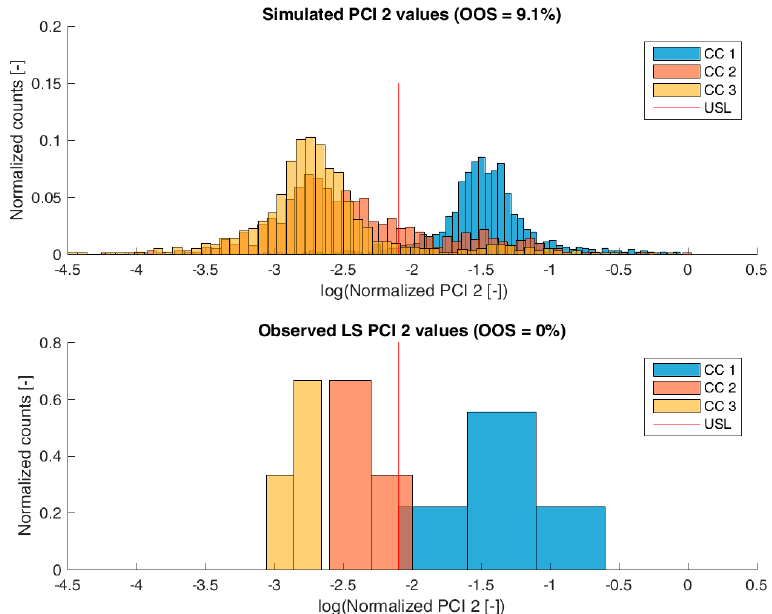
Figure 6. Comparison of simulated ( top ) process-related impurity 2 distribution and observed ( bottom ) process-related impurity 2 from LS after each column step. Normalization was performed by dividing by the maximum observed c CQA